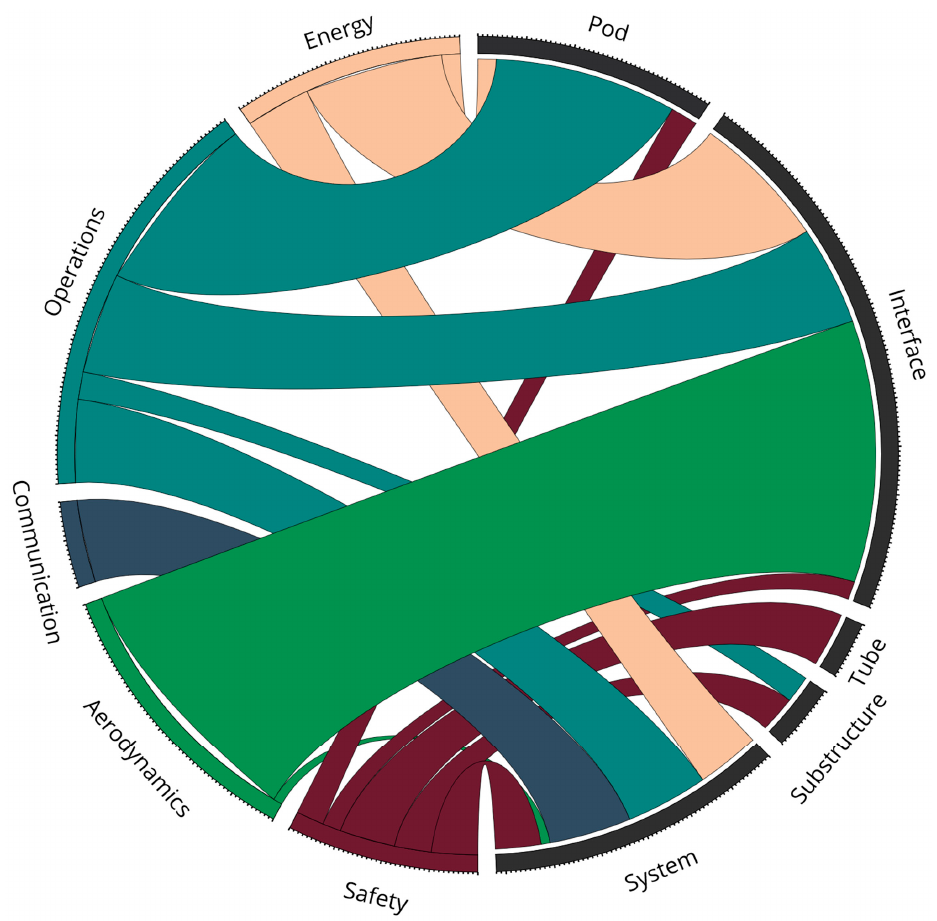
Figure 3. Hyperloop academic research clusters relation overview.